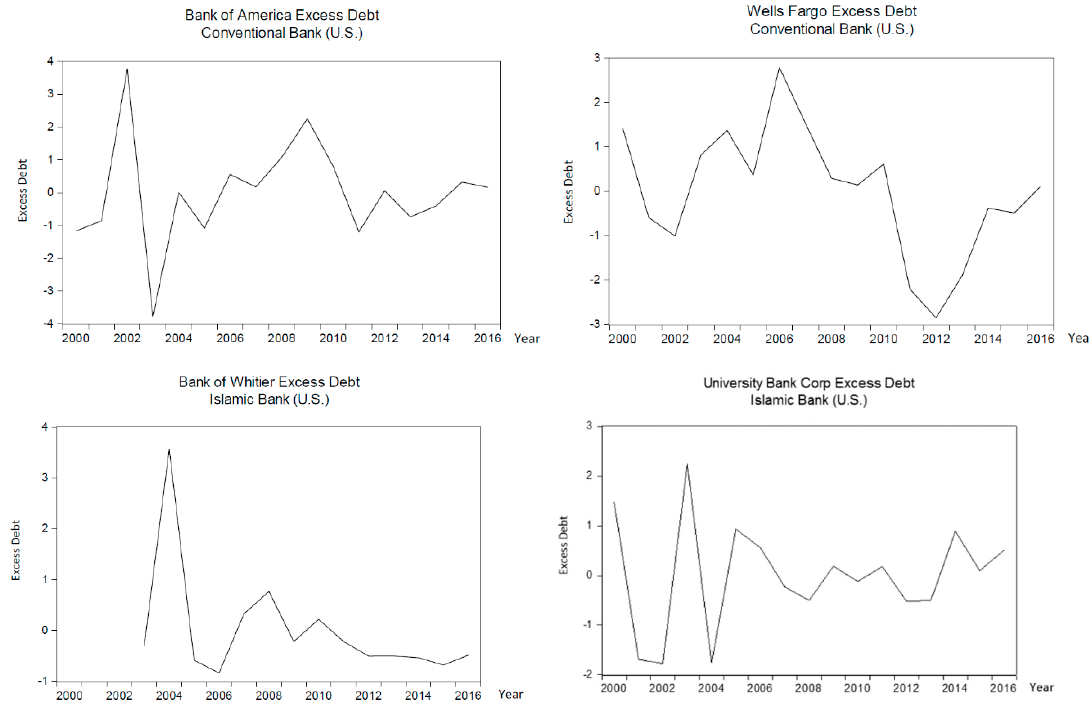
J. Risk Financial Manag. 2020 , 6 , x FOR PEER REVIEW Figure 9. United States excess debt. Source: Author’s calculations. Figure 9. United States excess debt. Source: Author’s calculations.